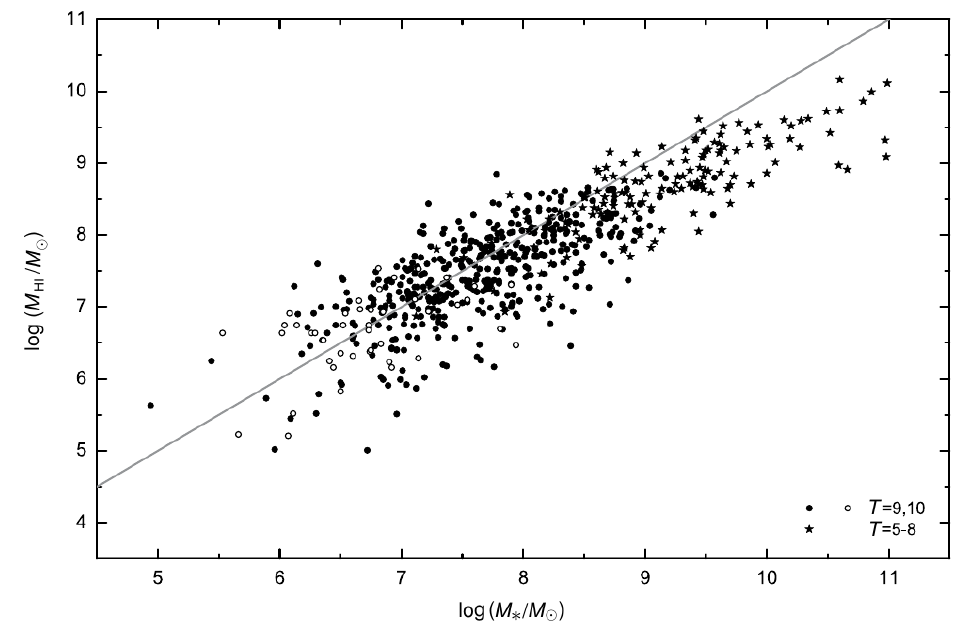
Figure 2. Neutral hydrogen versus stellar masses of late-type galaxies ( T = 5–10) in the local volume ( D < 11Mpc). Open circles denote galaxies with upper H I flux limits. The solid line connects points with equal H I and stellar masses from